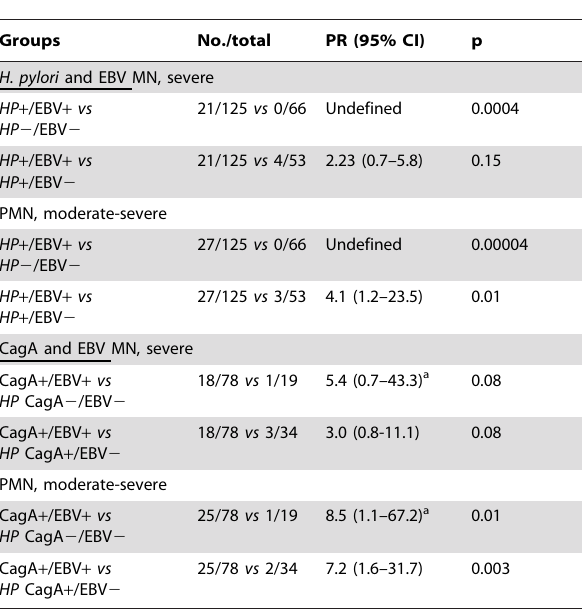
Table 4. Age adjusted PR values for severe MN and moderate-severe PMN infiltration when compared between co-infected children against without infection or with single H. pylori